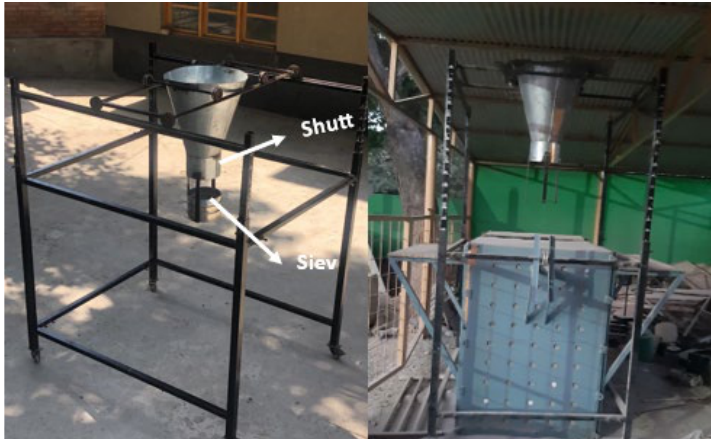
Figure 5. Mobile pluviator installed above the soil box.